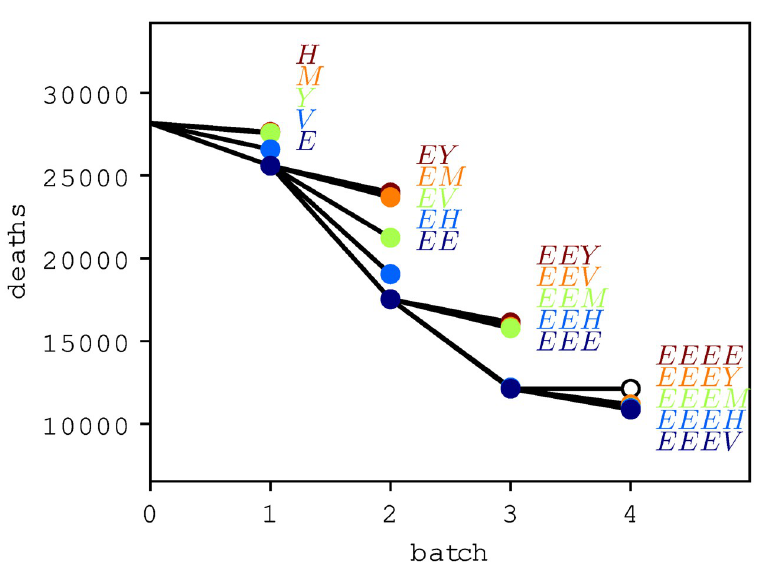
Fig 4. Accumulated model results for daily COVID-19 caused deaths for all the simulations performed during the iterative optimization. After each step / batch, the simulation enhances the batch-notation that yielded the best results for the target variable. In the last iteration, EEEE led to an invalid plan since the corresponding group G fully vaccinated after EEE